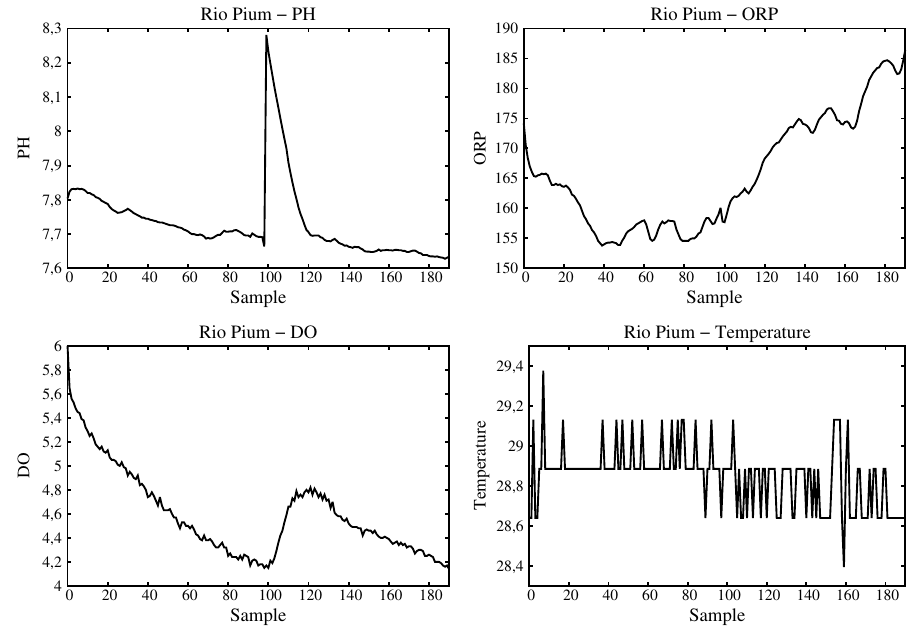
Figure 13. Data acquired and processed for Pium